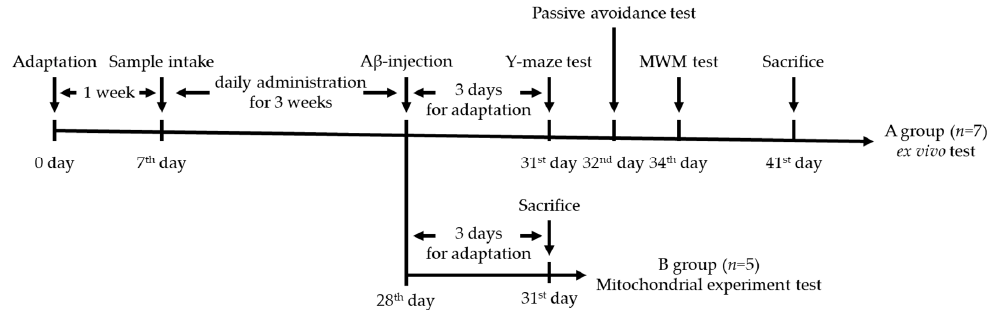
Figure 1. Experimental design of the in vivo test for amyloid beta (A β )-induced mice.